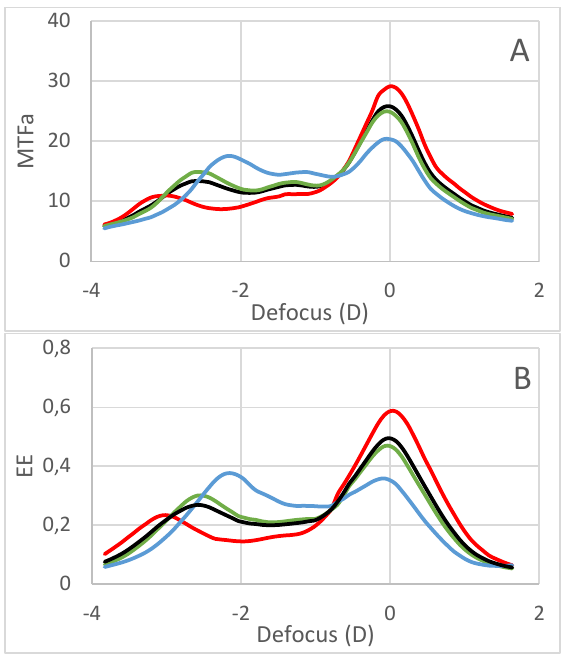
Fig. 3. Clinical Visual Acuity versus polychromatic (A) MTFa_Poly and (B) EE_Poly for 3mm pupil (blue dots). Exponential fits (green